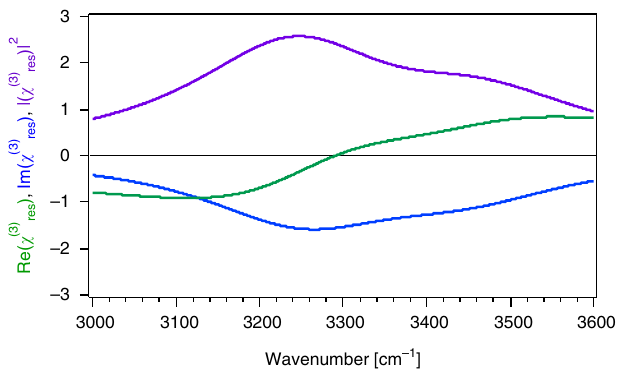
Fig. 3 Resonant χ (3) res lineshape. Real and imaginary portions and square modulus of the χ (3) res response from a dual-oscillator system in the diffuse layer over a charged surface simulated for ω 1 = 3250 cm − 1 , γ 1 = γ 2 = 0°, ω = 3450 cm − 1 , Γ = Γ = 150 cm − 1 , χ (3) = 200, and χ (3) = 2 1 2 1 2